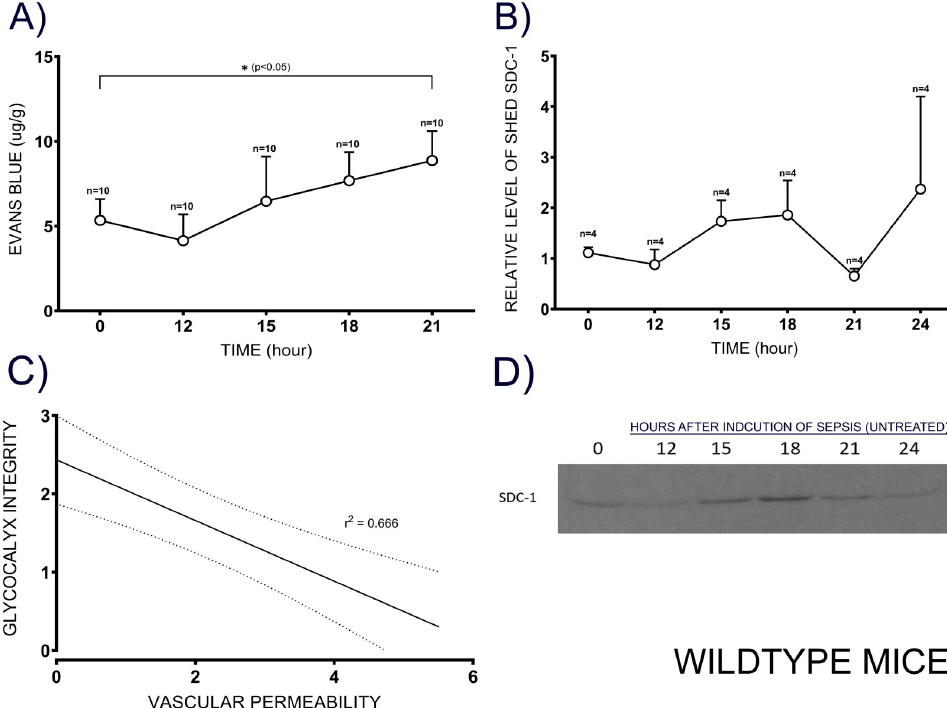
Fig 2. Association between vascular hyper-permeability and integrity of EGL. To evaluate vascular hyper- permeability (A), Evans blue dye was intravenously injected into WT mice (10 animals per time point) 30 min before euthanasia. The free dye was washed out, and the Evans blue concentration in the lung homogenate was determined at 620 nm. Circulating shed Sdc-1 was measured in the serum collected (4 mice per time point) at indicated time points after the induction of sepsis by immunoblotting (B, D). A moderate negative association was found between glycocalyx integrity and vascular hyper-permeability (C), and the non-continuous line indicates confidence interval (95%). Data are expressed as mean ± SEM ( � p <